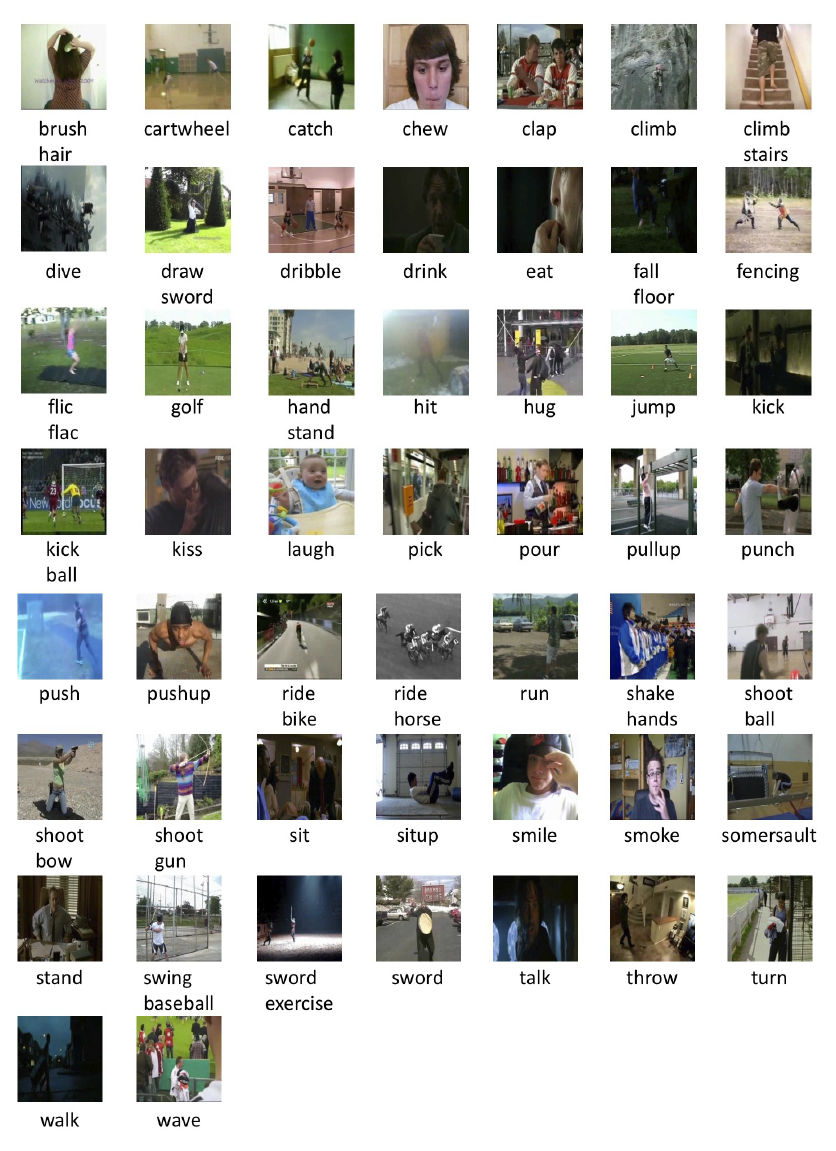
Figure 4. Illustration of the sample frames from video clips for all 51 human action